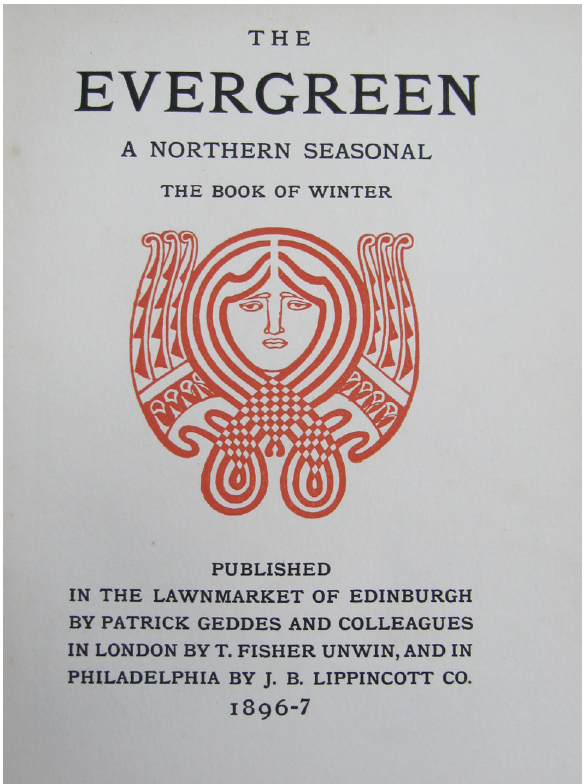
Evergreen: A Northern Seasonal (Winter, 1896–7), title page, private collection.